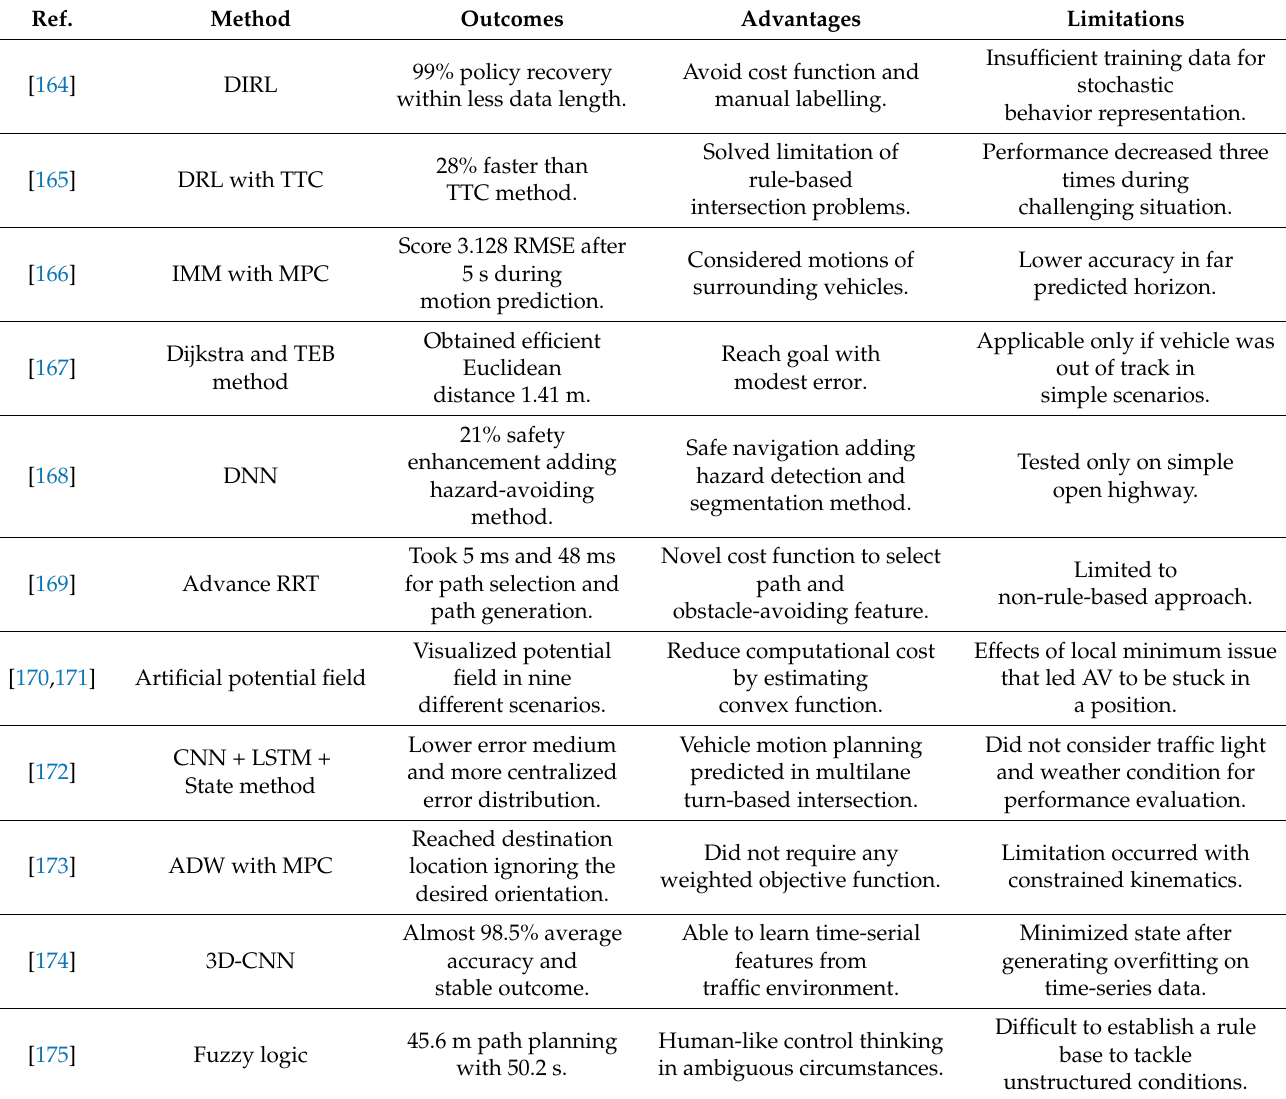
Table 12. Summary of multiple deep learning methods for path and motion